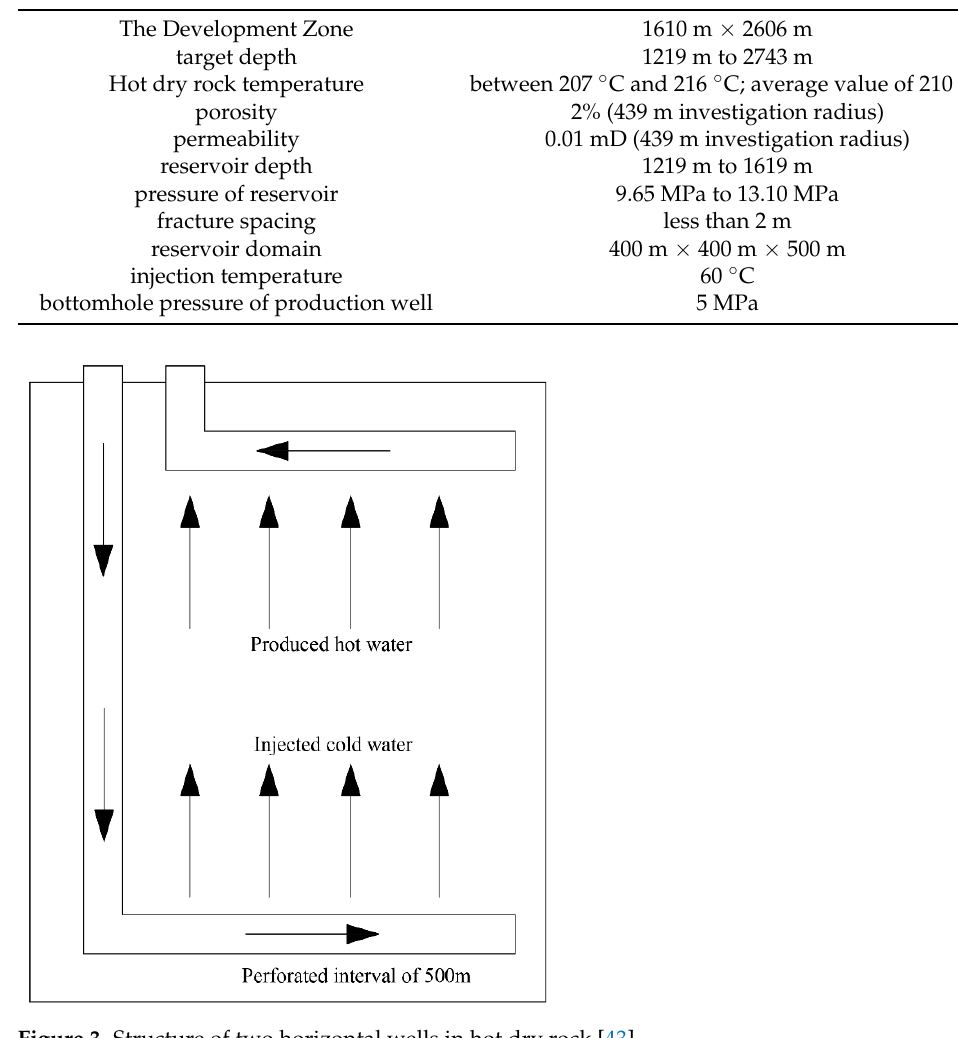
Figure 3. Structure of two horizontal wells in hot dry rock